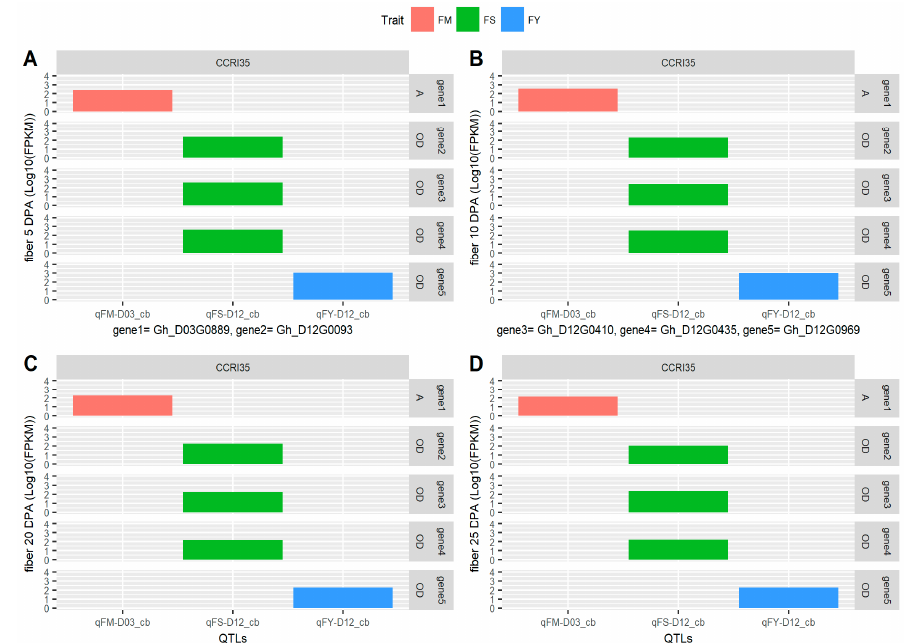
Figure 8. The five genes with highest expression in different stages of fiber development. x axis: QTLs for fiber Quality; CCRI35: good fiber quality parental line; y axis: fiber DPA (Log10(FPKM)); FM: fiber micronaire (%); FS: fiber strength (cN/tex); FY: fiber yellowness; Gh_D03 or Gh_D12 are genes identified with high expression and involved in fiber development; cb: combine analysis; 0 <Ae (additive